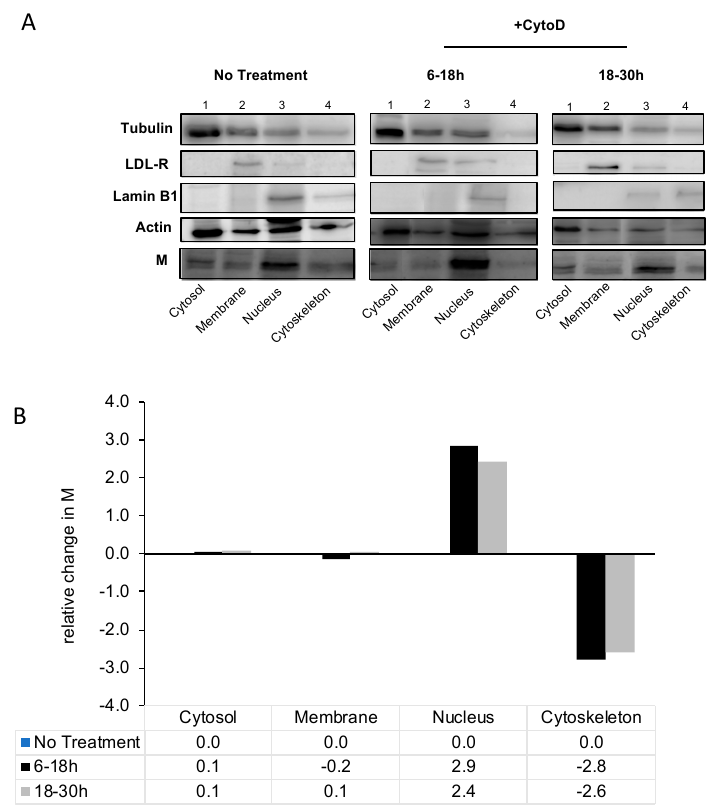
Figure 2. RSV M localizes to the nucleus upon microfilament destabilization. ( A ) A549 cells were cultured overnight and infected with RSV A2 at MOI = 1. Infected cells were either left untreated ( − CytoD), treated (+CytoD) early in infection (6–18 h), or late in infection (18–30 h). Subcellular fractionation was undertaken to determine the presence of RSV M in cytosol, membrane, nuclear, and cytoskeletal fractions against several antibodies as controls. Controls used include anti-tubulin antibody (marker for the cytosol), anti-LDL-R (marker for membrane), anti-lamin B1 (marker for the nucleus), and anti- β -actin (marker for cytoskeleton) as shown. ( B ) Quantitative analysis of the subcellular fractionation blot as shown in ( A ) was undertaken to determine the percentage change in RSV M in each fraction after CytoD treatment, relative to no treatment.